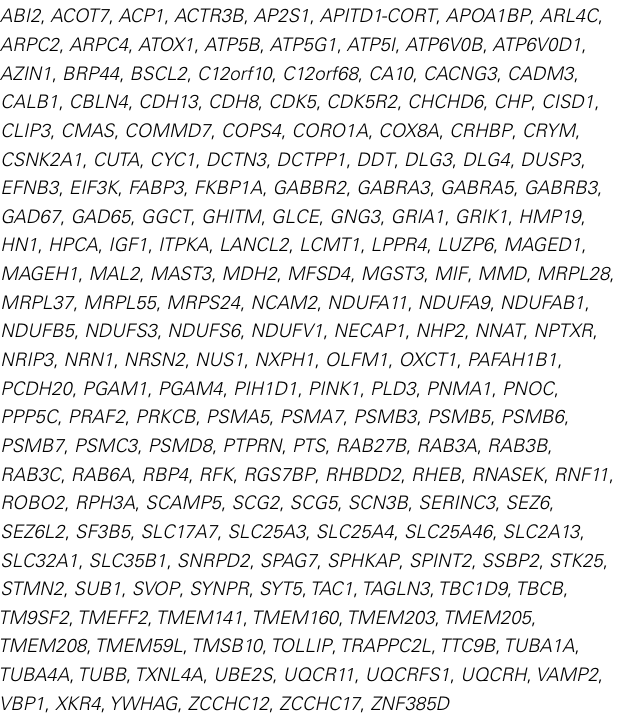
Table 4 |Top 200 genes correlated with SST in human frontal